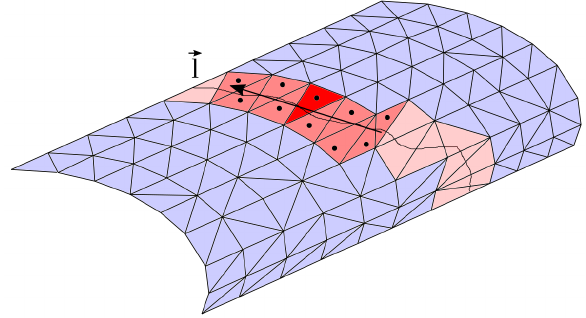
Figure 8. Determination of direction of the crack edge (cid:126)l . The triangle with the strong red color is the triangle which (cid:126)l is computed for. The center points of the triangle and the deformed neighbor triangles are shown as black points, the deformed neighbor triangles have a less strong red color. The blue triangles are undeformed. The fitted line direction vector (cid:126)l is depicted in black.